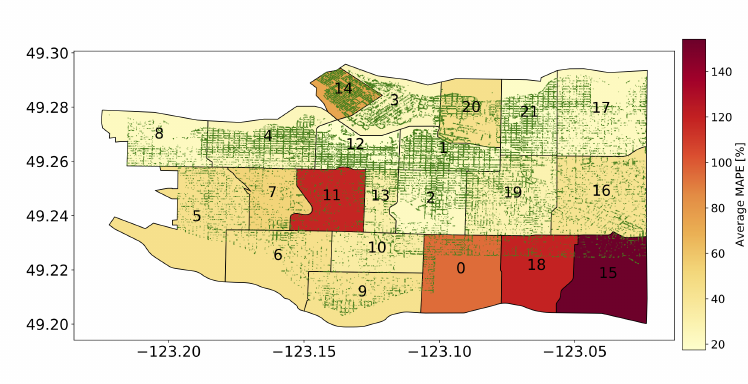
Figure 13. Spatial distribution—Heatmap of average MAPE per neighborhood. Rentals are shown on the map as green